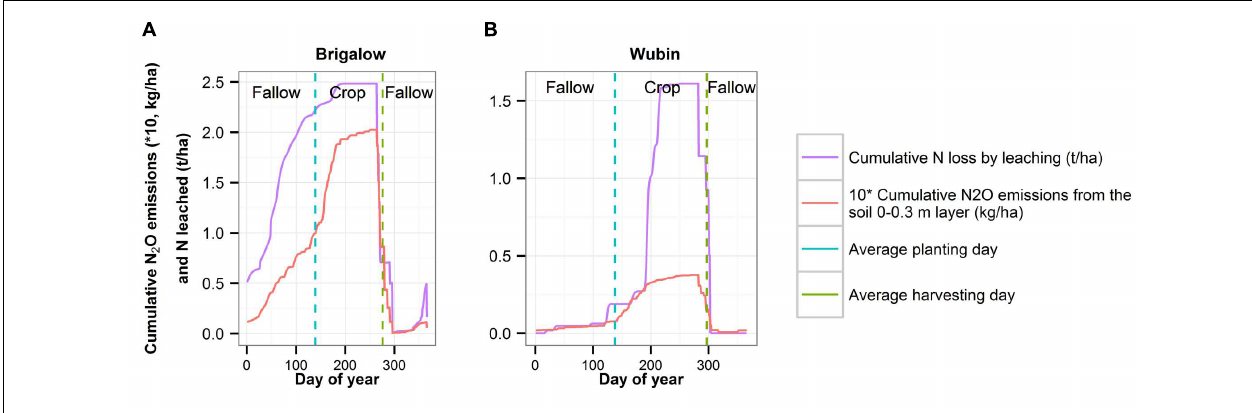
FIGURE 9 | Simulated cumulative N 2 O emissions and cumulative N loss by leaching during the fallow and the crop periods for Brigalow soil + climate (A) and for Wubin soil + climate (B). Conditions simulated: wheat-wheat rotation with a fertilization rate of 50 kg N/ha/year, average of the last 10 years of the